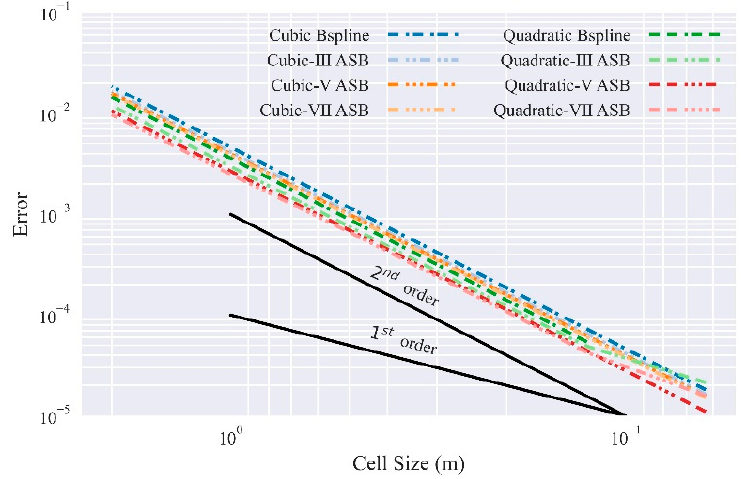
Figure 10. Spatial convergence of ASBMPM variants for the problem of 1D axial vibration bar.